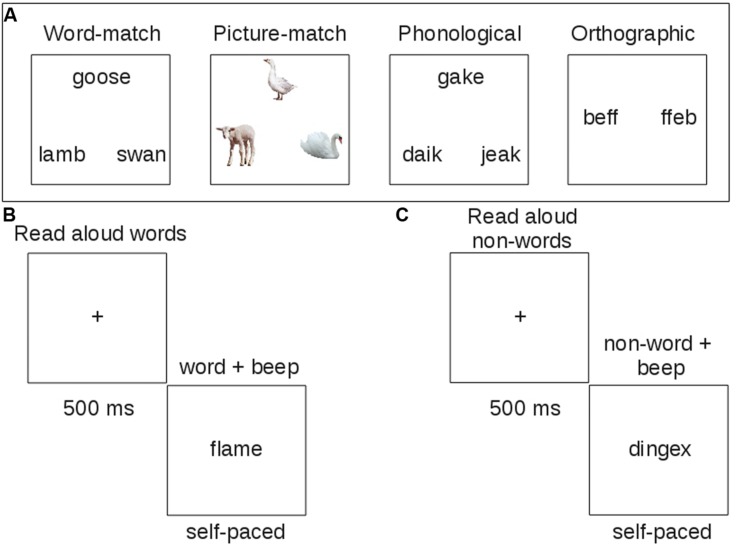
Example trials of behavioral tasks administered to patients. Each task was designed to measure one component of reading. (A) Touch-screen tasks; (B) reading aloud task with words; (C) reading aloud task with non-words.